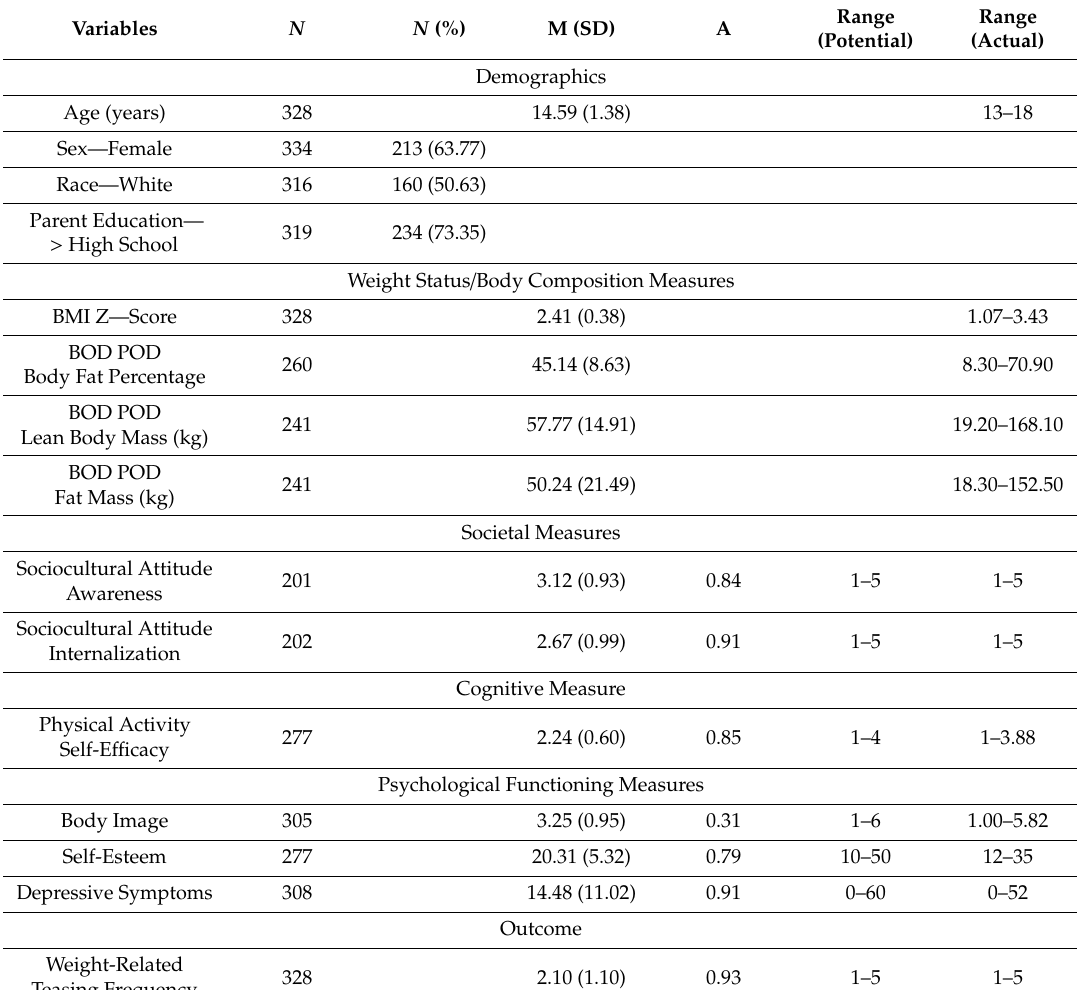
Table 1. Properties of the Major Study